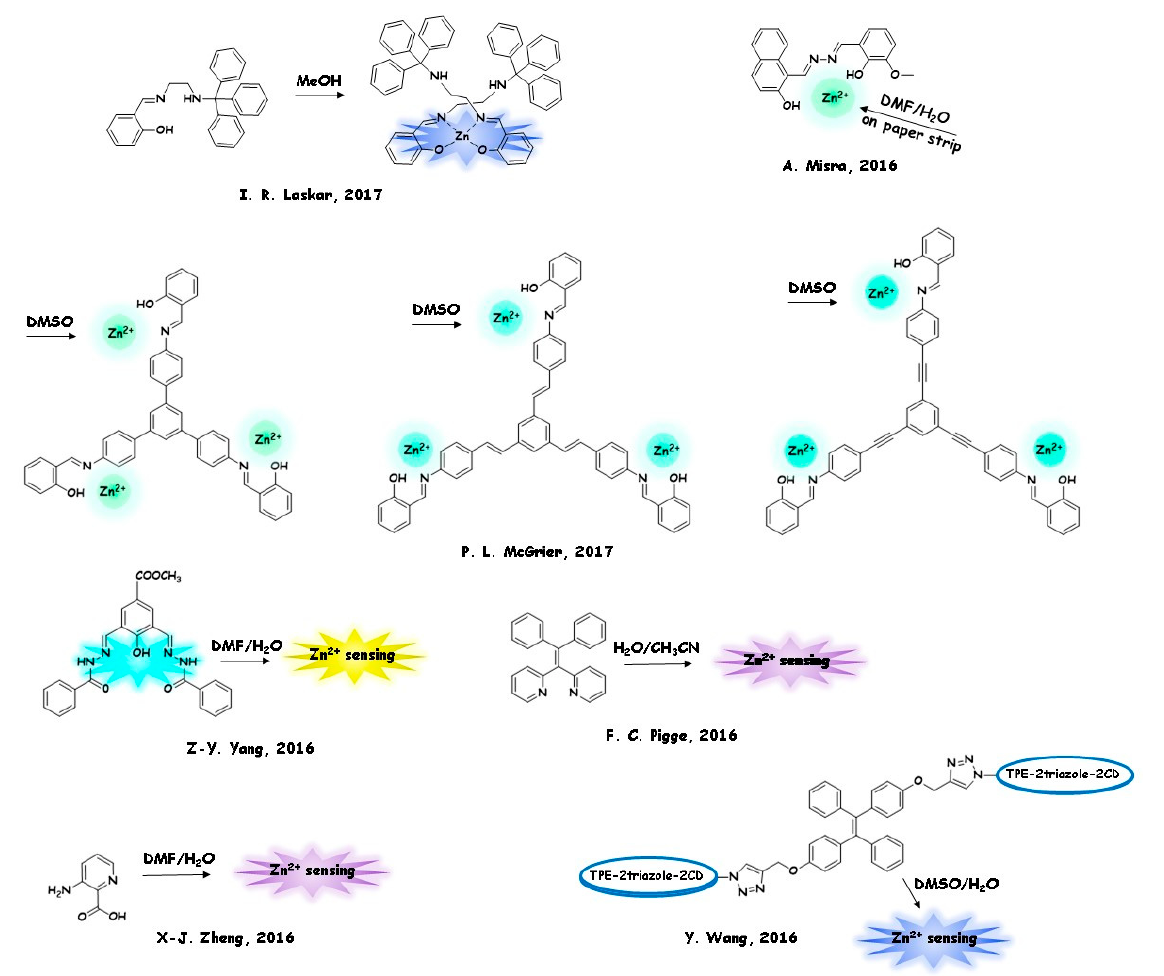
Figure 4. AIEgens acting as zinc (II) mono-channel sensor.